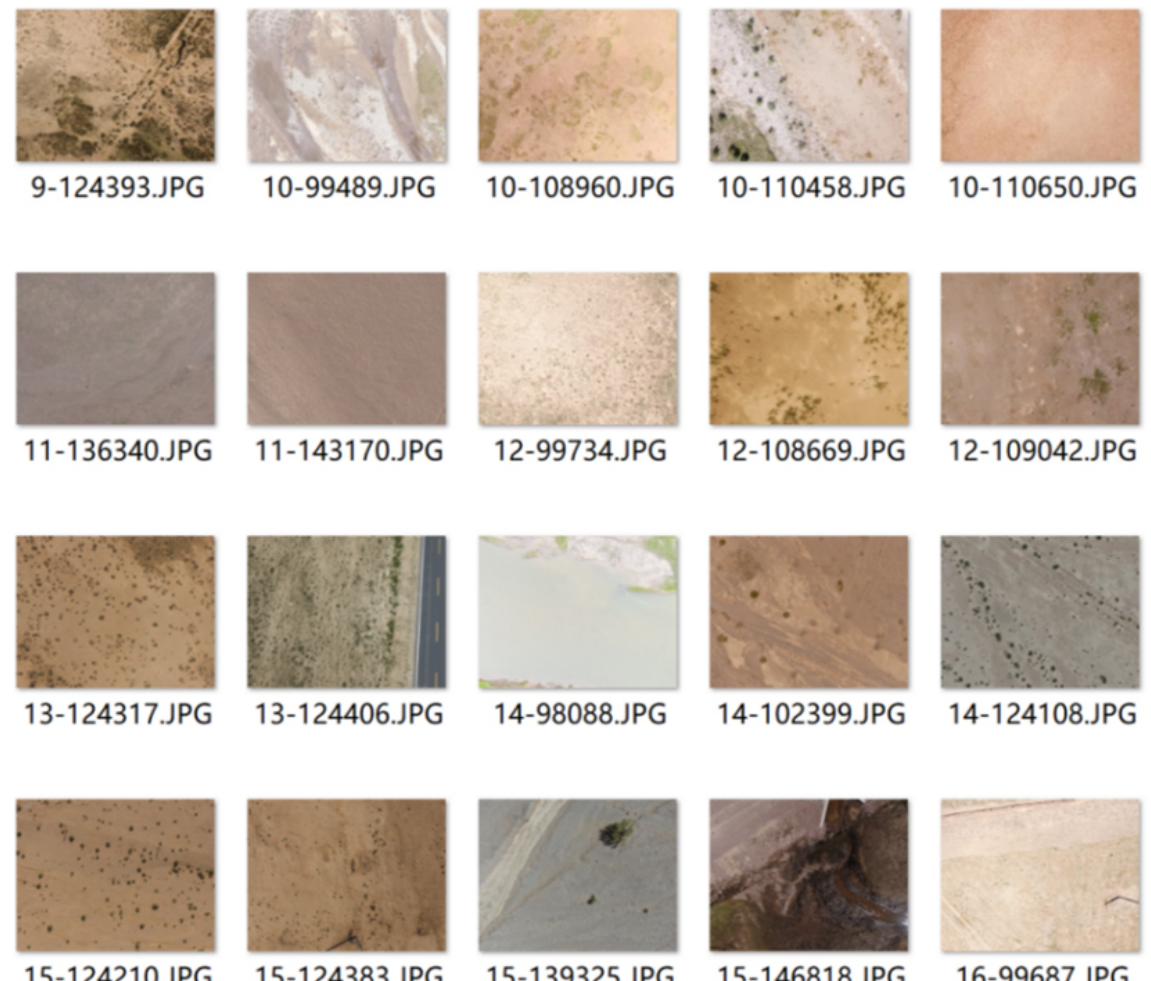
Figure A5. Examples of 20m high UAV photos with different non-vegetation background information.